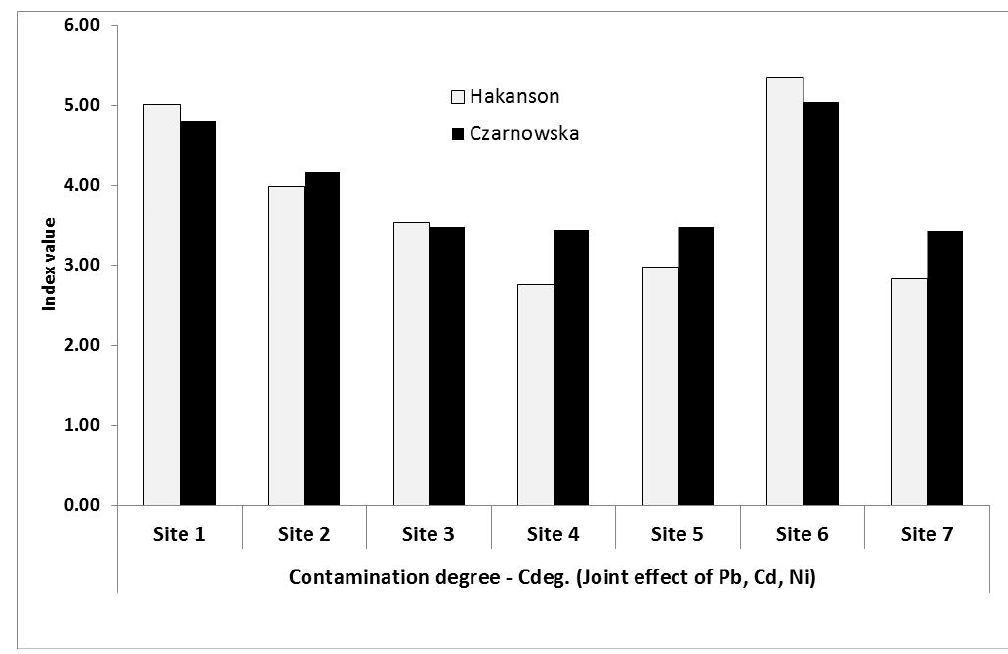
Figure 3. Site distribution of contamination degree indices ( C deg ) within the Kampinoski National Park ( C deg assayed on the basis of Håkanson and Czarnowska background values, Table 1).